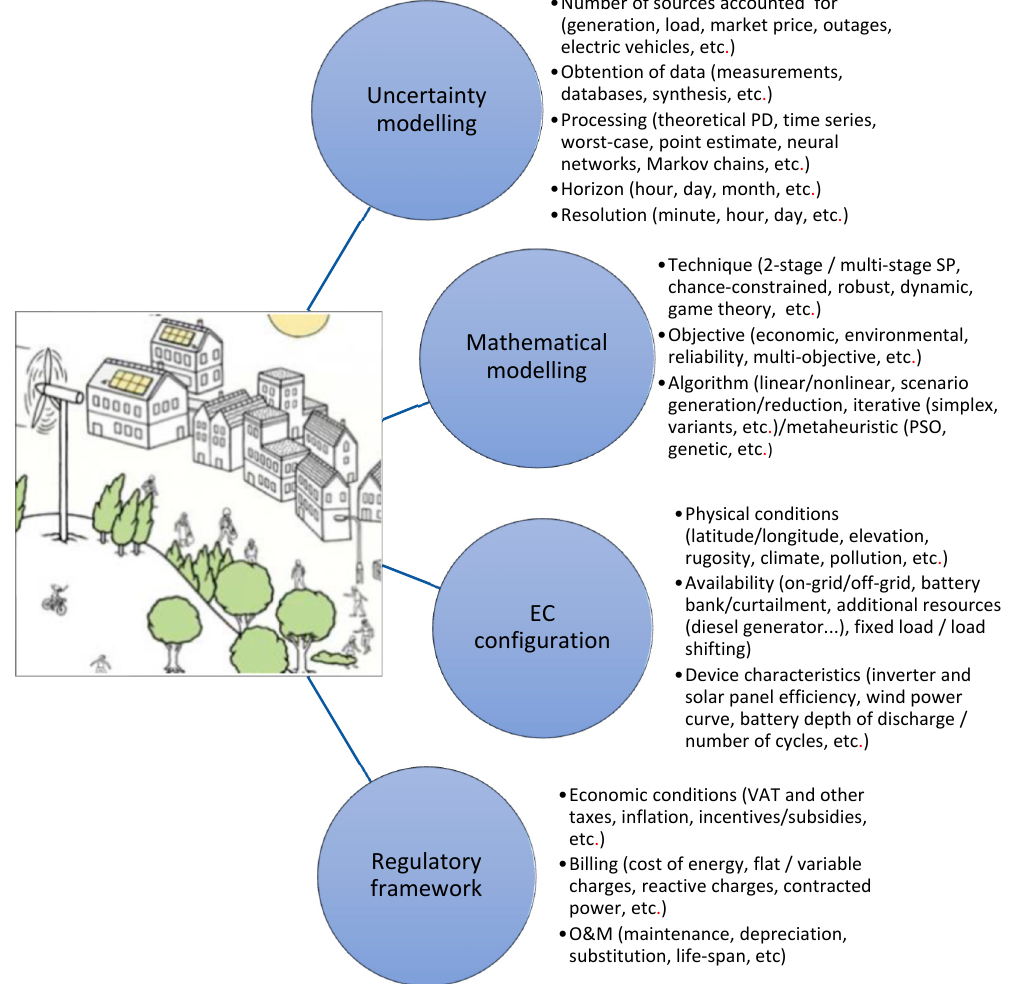
Figure 1. Diagram of the microgrid model and its different subdivisions. Source: self-elaboration and River Cottage © .